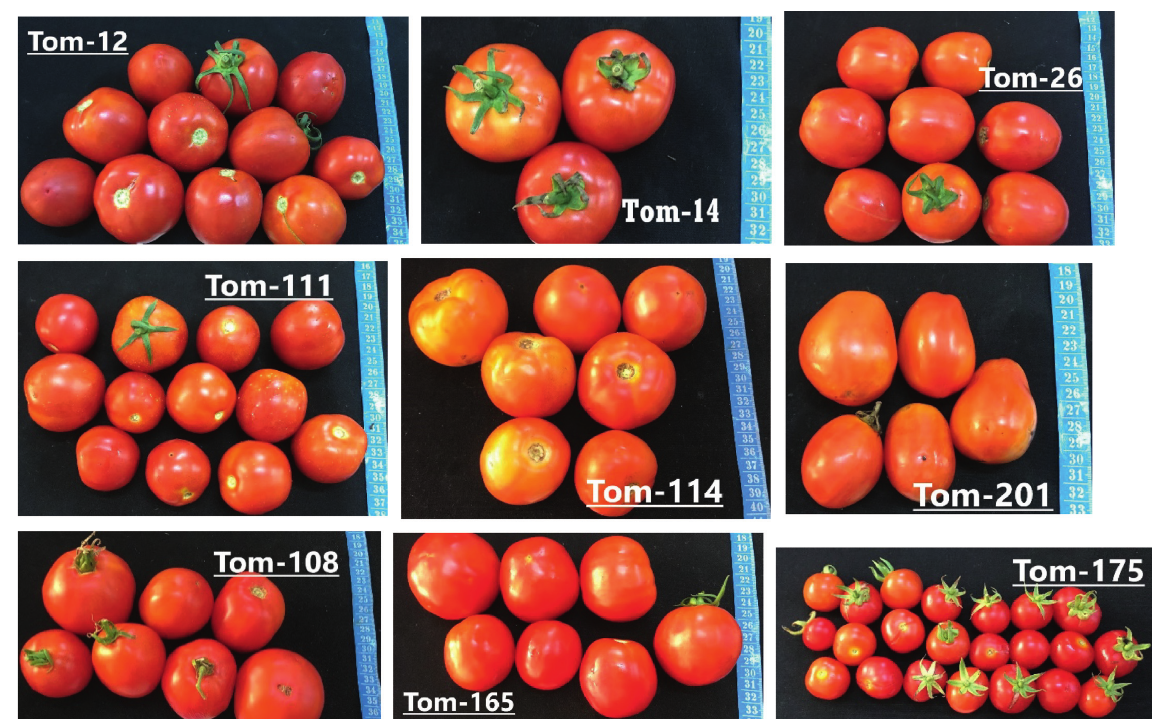
Figure 2: Fruits of some tomato genotypes used in the